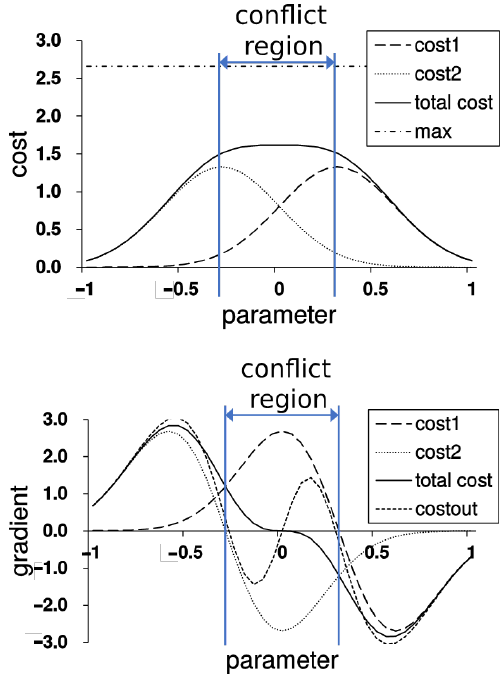
Figure 1. Cost landscape for combined and decomposed costs. ( top ) gradient conflict in cost per- spective. ( bottom ) gradient conflict in gradient perspective. (cost1: a normal distribution N ( 0.3,0.3 ) , cost2: N ( − 0.3,0.3 ) , total cost: sum of cost1 and cost2, max: sum of optima of cost1 and cost2, costout: the expected gradient calculated in Equation